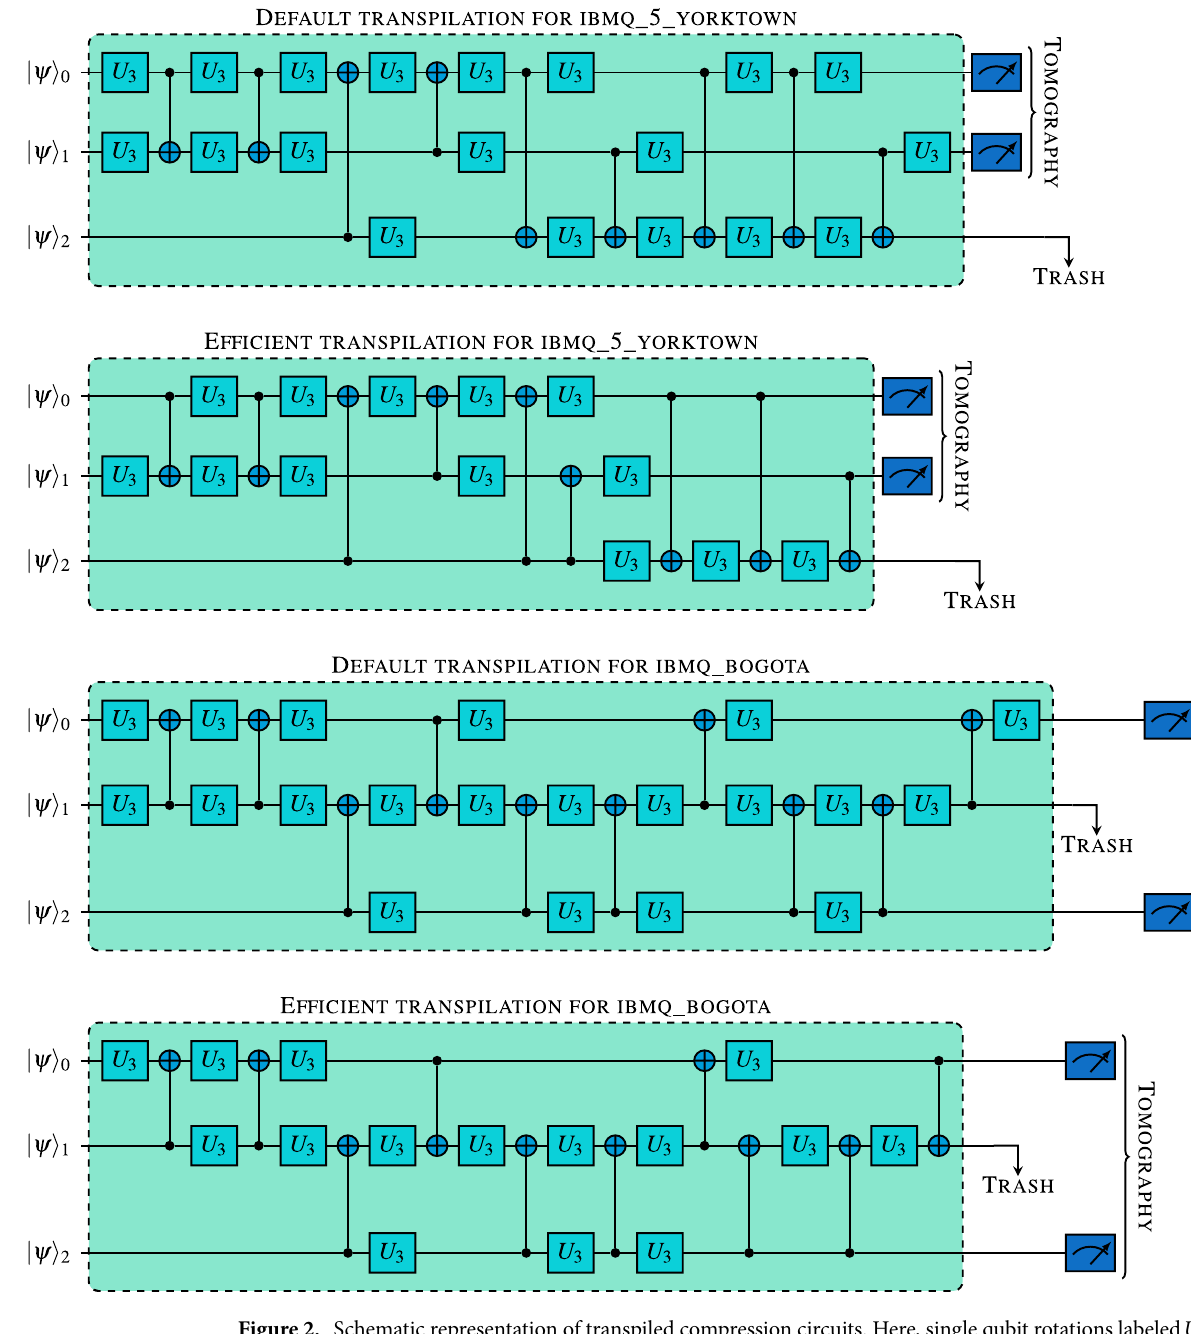
connectivity qubit 1 is